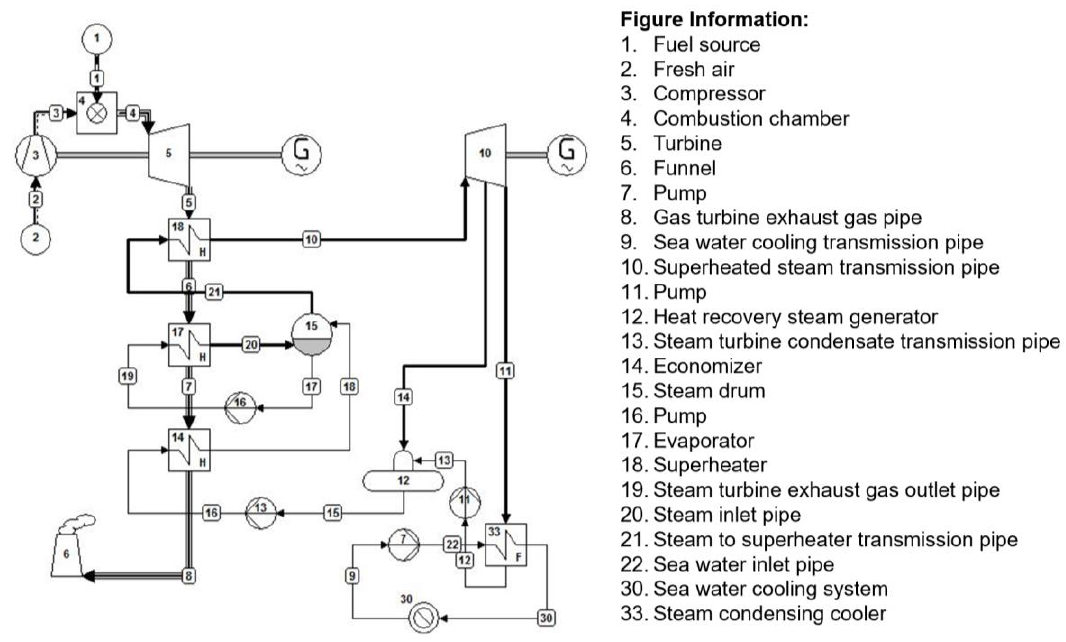
Figure 2. Schematic of a combined-cycle propulsion system.